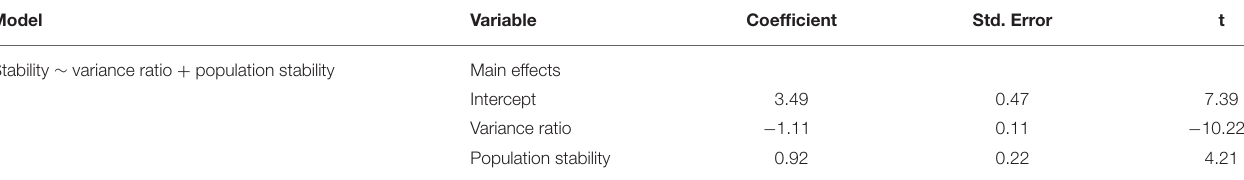
TABLE 4 | Model output from the linear mixed effect model predicting stability as a function of biotic mechanisms. Model Variable Coefficient Std. Error